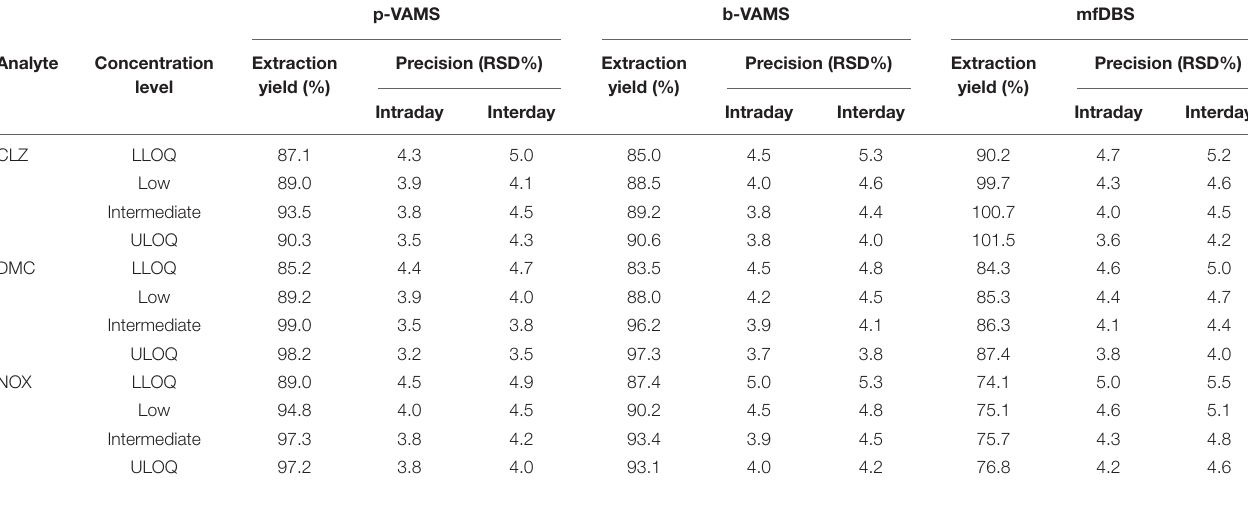
TABLE 2 | Extraction yield and precision results of spiked b-VAMS, p-VAMS, and mfDBS samples. p-VAMS b-VAMS mfDBS Analyte Concentration